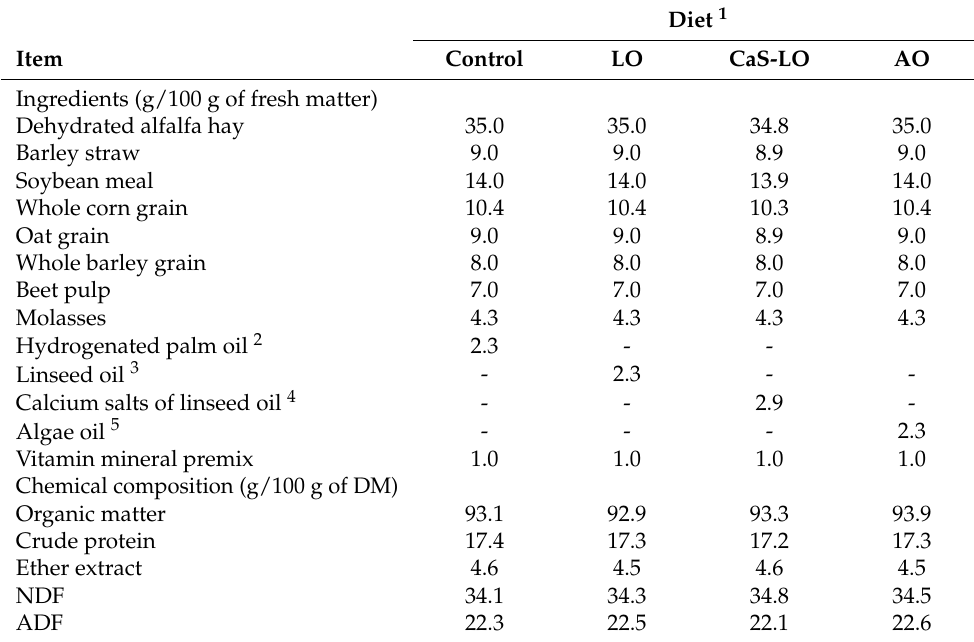
Table 1. Ingredients and chemical composition of the experimental diets.